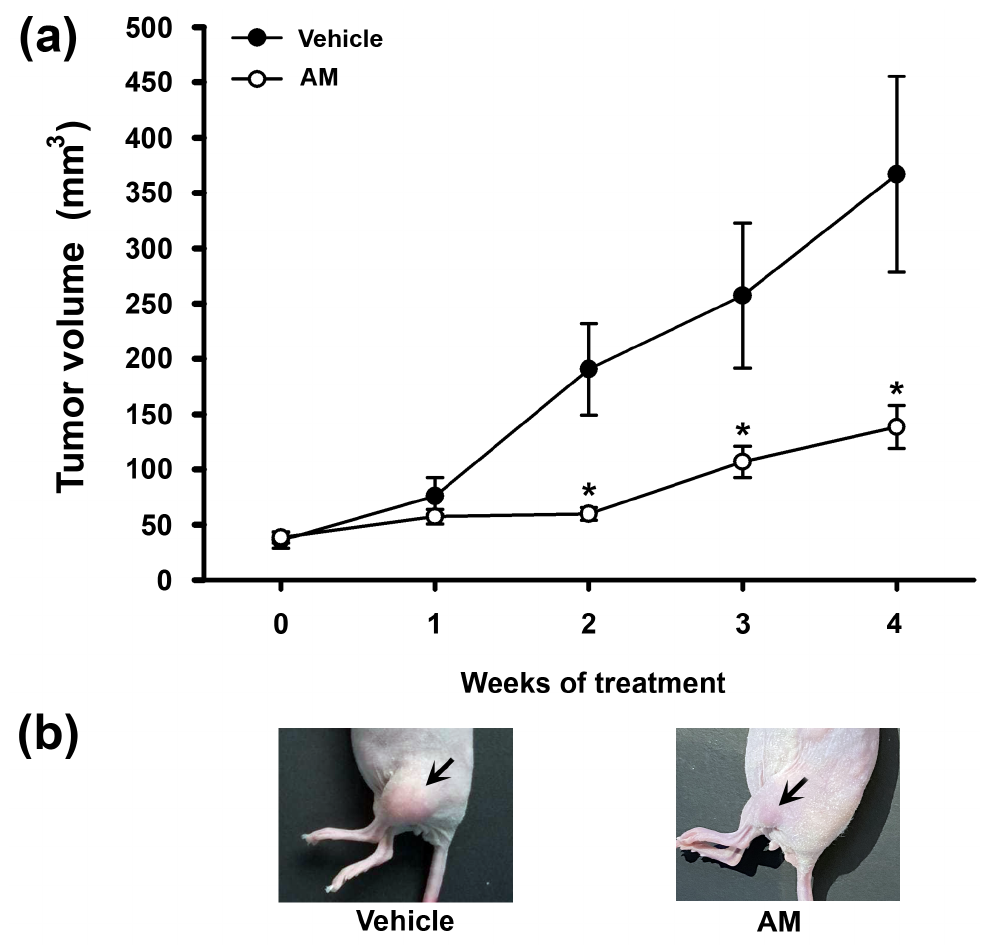
Figure 4. AM administration slows cervical tumor growth. SiHa cervical cancer cells were subcutaneously xenografted (2 × 10 6 cells) into the lower limb of each mouse. Mice were randomly divided into two groups when the tumors reached a palpable mass of ~5 mm in diameter, and received either vehicle (0.1% of DMSO/day, black circles) or α -mangostin (AM, 8 mg/kg of body weight/day, white circles) in the drinking water for four weeks. ( a ) The tumors were measured every week with a caliper, and the tumor volume was estimated. The results are the mean ± SEM of tumor volume. ( b ) Representative pictures depict the tumor’s final size at the end of the treatment. In the vehicle and AM-treated groups, 9 and 10 mice were included, respectively. * p < 0.05 vs. vehicle.